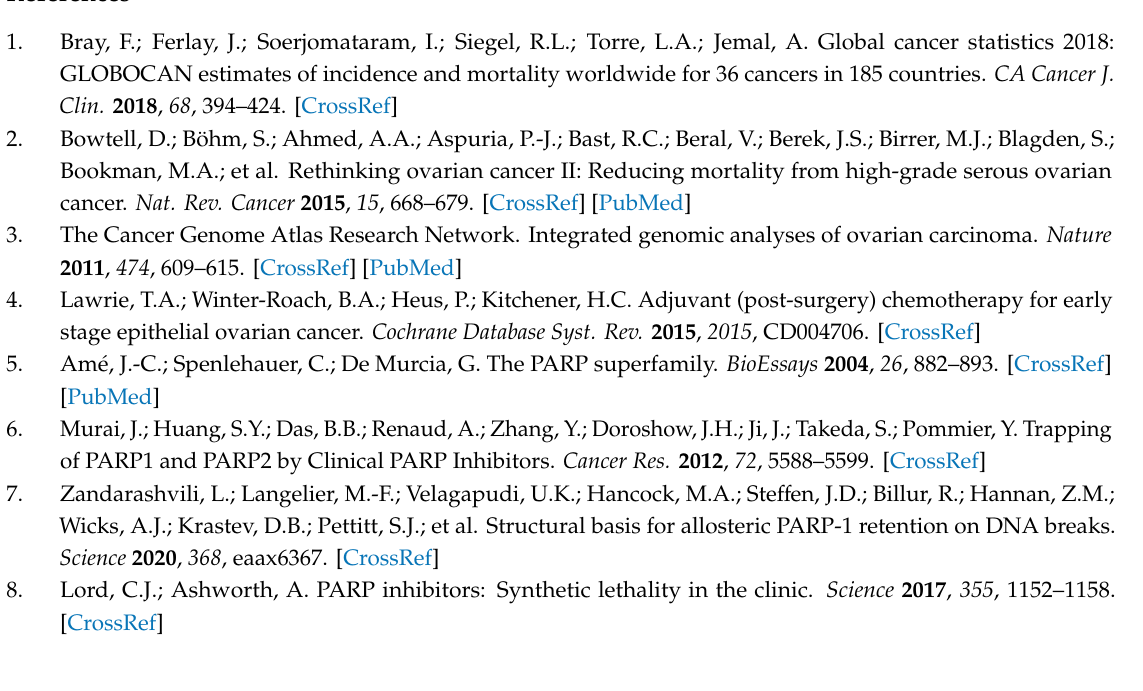
Figure S1: Information in support of Western blots shown in Figures 3 and 4, Table S1: Antibodies used for Western